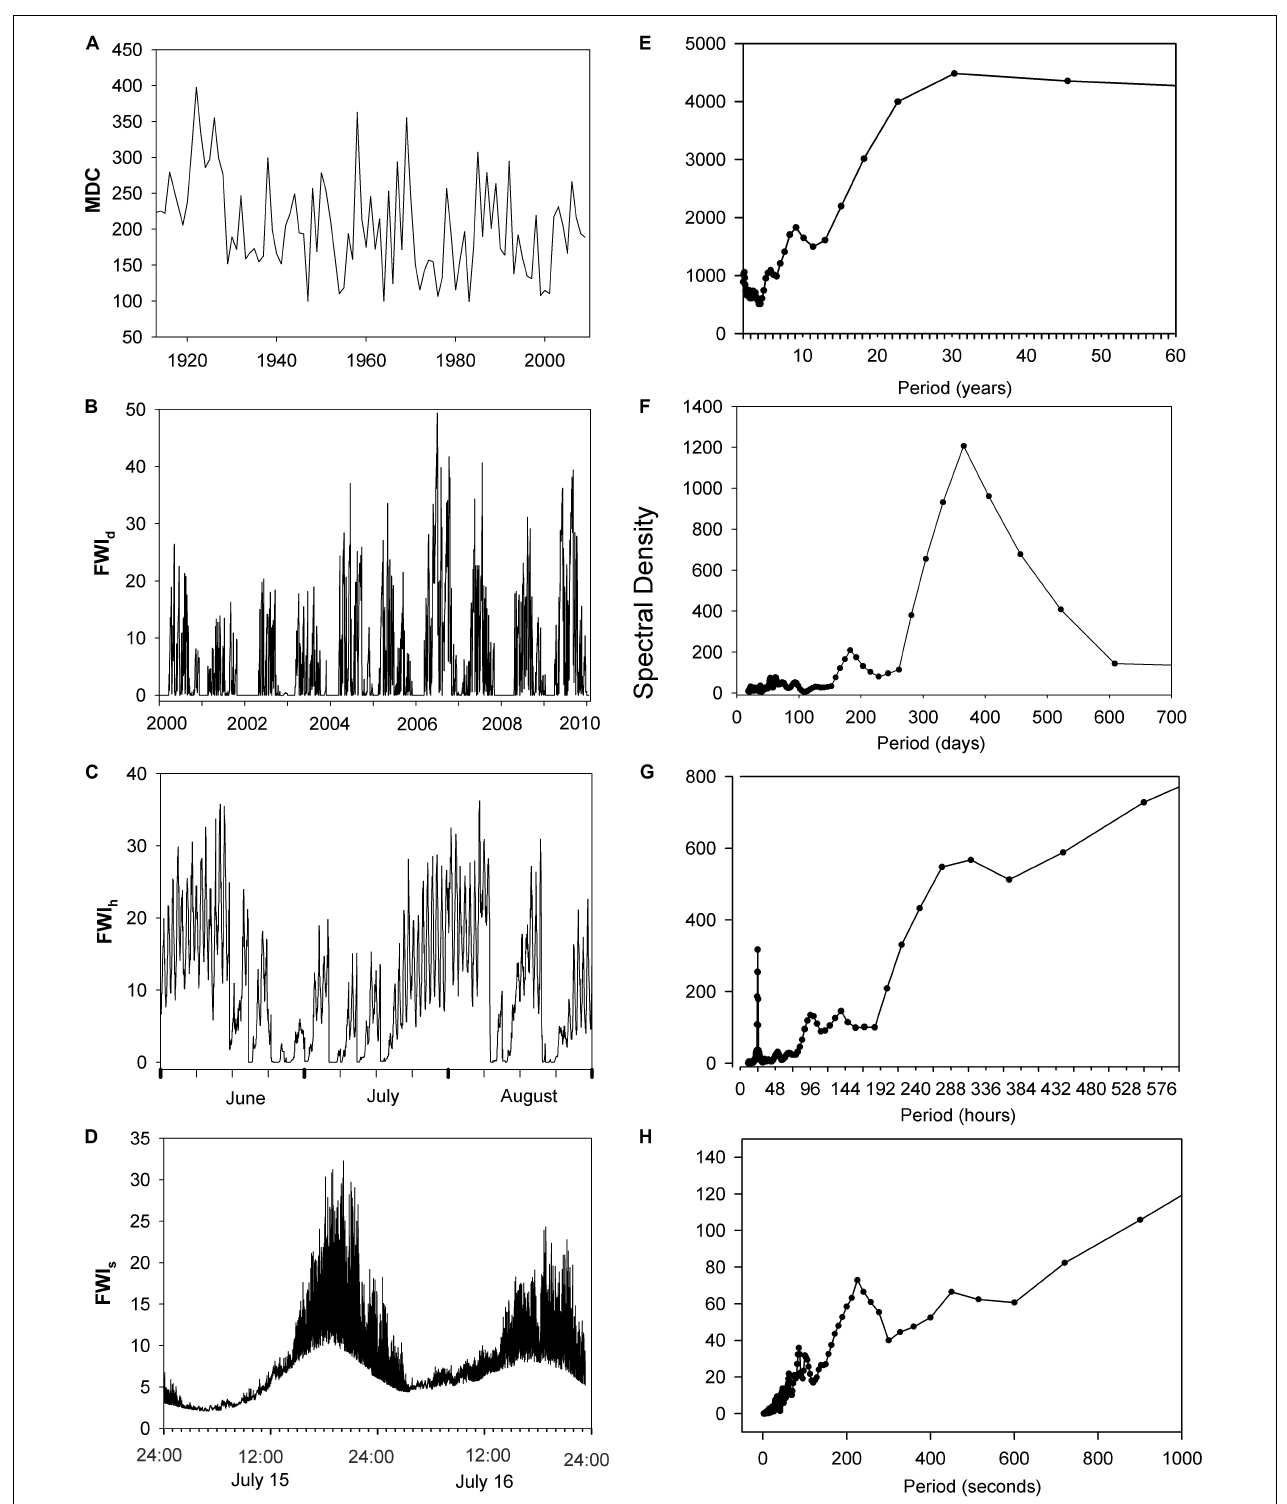
FIGURE 5 | Left panel: FWI System values (FWId, FWIh, FWIs are the Fire Weather Index estimated at daily, hourly, and 1 s time scales, respectively.) observed at different time scales in the Montane Cordillera ecozone. (A) Monthly Drought Code during July, 1912–2018, Prince George, BC; (B) FWId during 2000–2010, Bear Lake, BC; (C) FWIh on June 1- August 31, 2009, Bear Lake, BC; (D) FWIs for July 15–16, 2009, MPB-03 site (see Figure 1 ; Table 2 ). Right panel: (E–H) Power spectral density (PSD) corresponding to the time series in the right panel, excepting H is the power spectra for a 1 h sample 18:00–19:00 on July 15,